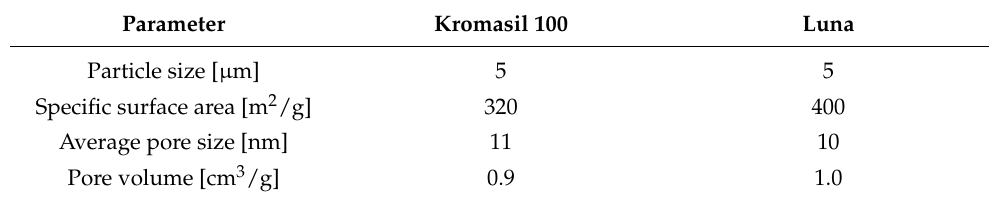
Table 2. Characteristic of silica gels used in the